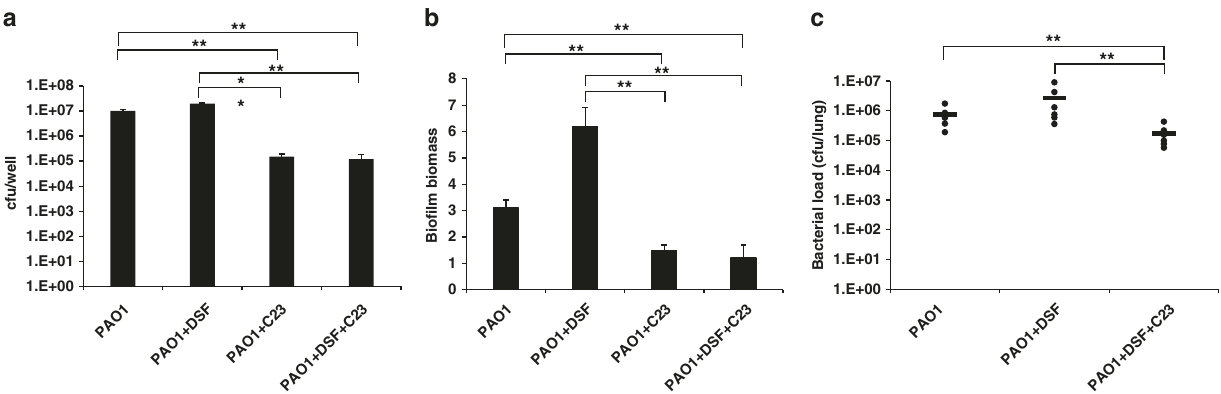
Fig. 4 Effects of analogs on DSF-induced virulence phenotypes of P. aeruginosa . a Effect of DSF and C23 alone or in combination on attachment of P. aeruginosa strains to CFBE epithelial cells. For these experiments, compounds (0.5 µ M) were added to the co-culture at 1 h and bacterial attachment to the CFBE epithelial cells was measured after 24 h (See Methods). A p- value of < 0.05 was considered statistically signi fi cant and is designated in the fi gures with an asterisk. Double asterisks indicate p- values of <0.01. b Effect of 0.5 µ M DSF and C23 alone or in combination on attachment of P. aeruginosa to a glass surface as assessed by crystal violet staining. Bio fi lm biomass is measured as a ratio of absorbance at 550 and 600 nm. Values given are the mean and standard deviation of three technical measurements. A p- value of <0.05 was considered statistically signi fi cant and is designated in the fi gures with an asterisk. Double asterisks indicate p- values of <0.01. c Effect of administration of C23 on P. aeruginosa mouse airway infection. C57BL/6 mice were infected intranasally with 1 × 10 7 CFU of P. aeruginosa PAO1 and treated by inhaling PBS with or without 50 μ M C23. After 24 h infection, the mice were euthanized, and bacterial loads were determined in lung homogenates. Each data point shows the results from an individual mouse. A p- value of <0.05 was considered statistically signi fi cant and is designated in the fi gures with an asterisk. Double asterisks indicate p- values of